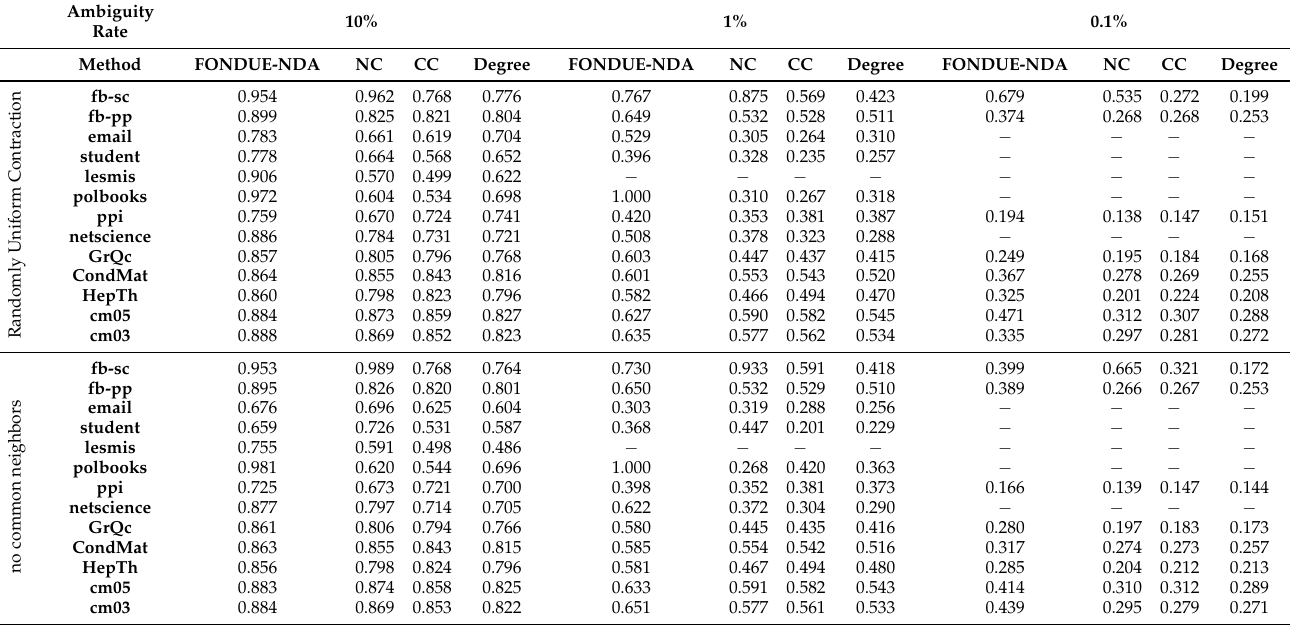
Table 3. Performance evaluation (NDCG) on multiple datasets for our method compared with other baselines, for two different contraction methods. Note that for some datasets with small number of nodes, we did not perform any contraction for 0.001 as the number of contracted nodes in this case is very small, thus we replaced the values for those methods by “ − ”. Ambiguity Rate 10% 1%